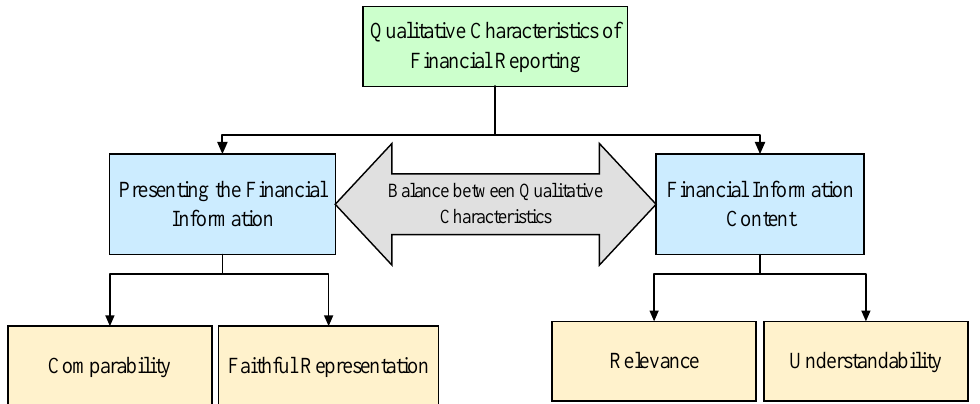
Figure 5. Qualitative criteria of financial reporting.